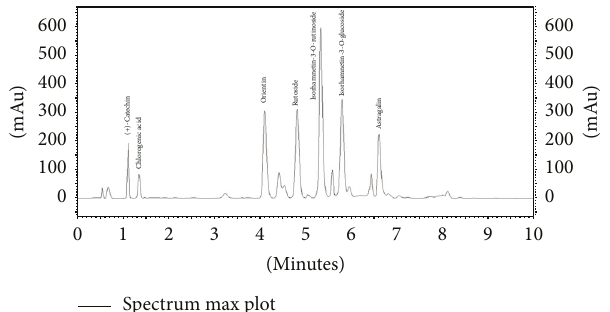
Figure 3: HPLC chromatogram of methanolic extract of the flowers of Primula veris .